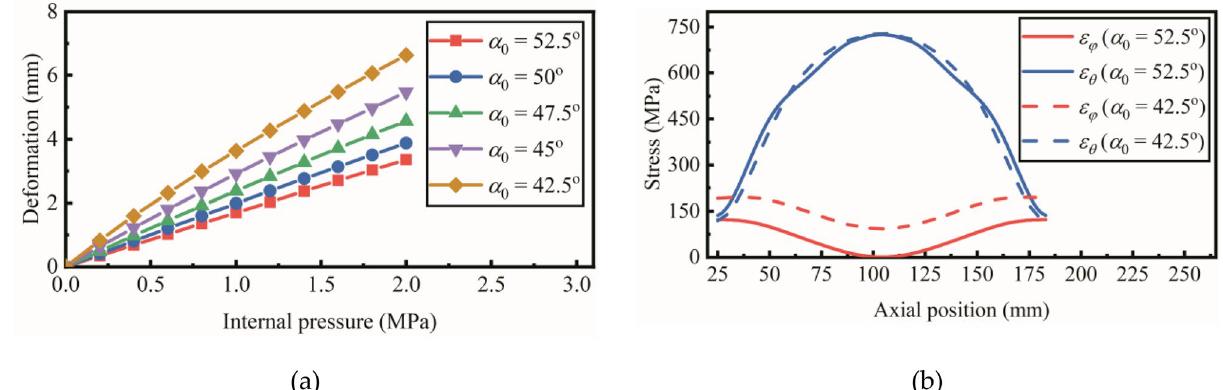
Figure 7. ( a ) Maximum deformation vs. the internal pressure with initial winding angle α 0 increased from 42.5 degrees to 52.5 degrees. ( b ) The inplane stress distribution of the reinforced layer while the internal pressure is 1.0 MPa and the initial winding angle is 52.5 degrees and 42.5 degrees.